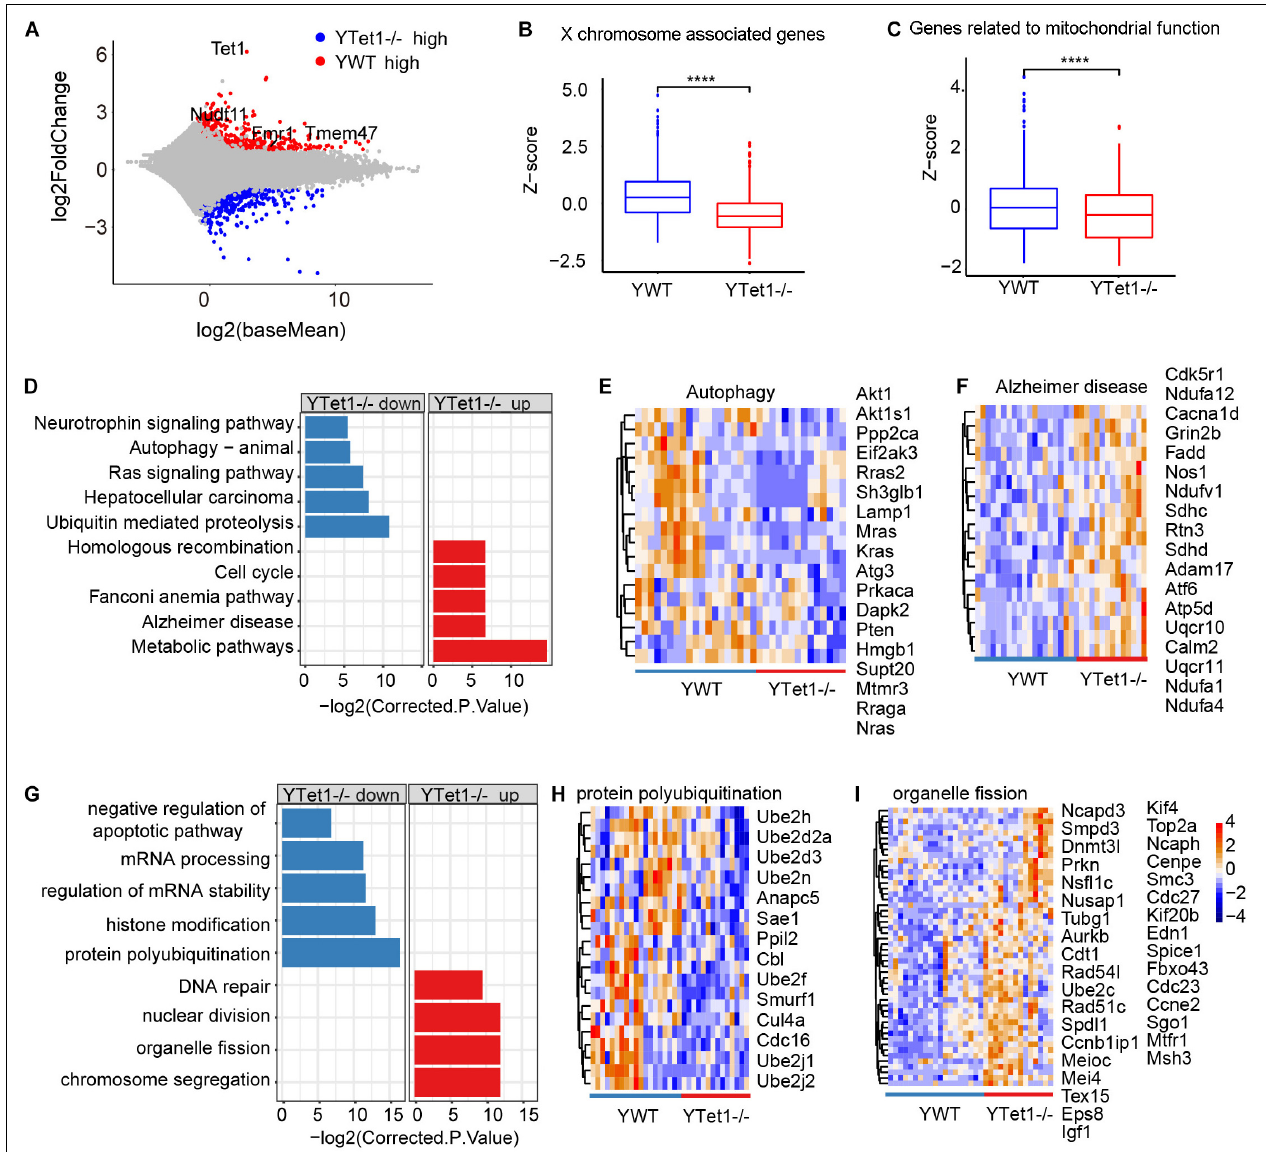
FIGURE 2 | Differential gene expression of Tet1 − / − and WT oocytes. (A) Scatter-plots showing gene expression profile between young Tet1 − / − ( n = 15) and WT ( n = 19) oocytes from two biological repeats. (B) Boxplot showing gene expression on chromosome X and downregulated in young Tet1 − / − oocytes compared with young WT oocytes. **** P < 0.0001. (C) Boxplot showing expression of genes on mitochondrial function and Downregulated in young Tet1 − / − oocytes. (D) KEGG enrichment results showing genes downregulated or upregulated after Tet1 deficiency. X -axis represents the corrected p value (FDR) using Benjamini and Hochberg. (E) Pheatmap showing genes enriched in autophagy signaling pathway down regulated in Tet1 deficient oocytes. (F) Pheatmap showing genes enriched in Alzheimer’s disease upregulated in Tet1 deficient oocytes. (G) GO enrichment results showing genes downregulated or upregulated after Tet1 deficiency. X -axis represents the corrected p value (FDR) using Benjamini and Hochberg. (H) Pheatmap showing genes enriched in protein polyubiquitination in Tet1 deficient oocytes. (I) Pheatmap showing genes enriched in organelle fission upregulated in Tet1 deficient